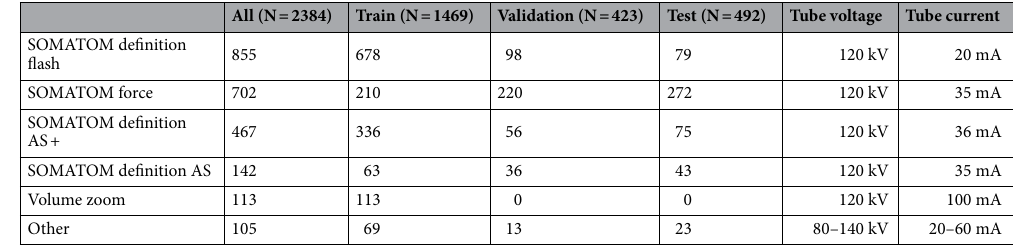
Table 3. CT scanners used to acquire the CT scout views. Scanners with less than 50 examinations were gathered into the “Other” group and contained 18 scanners (for example, SOMATOM Emotion 6, Emotion 16, Sensation 4, Sensation 16,